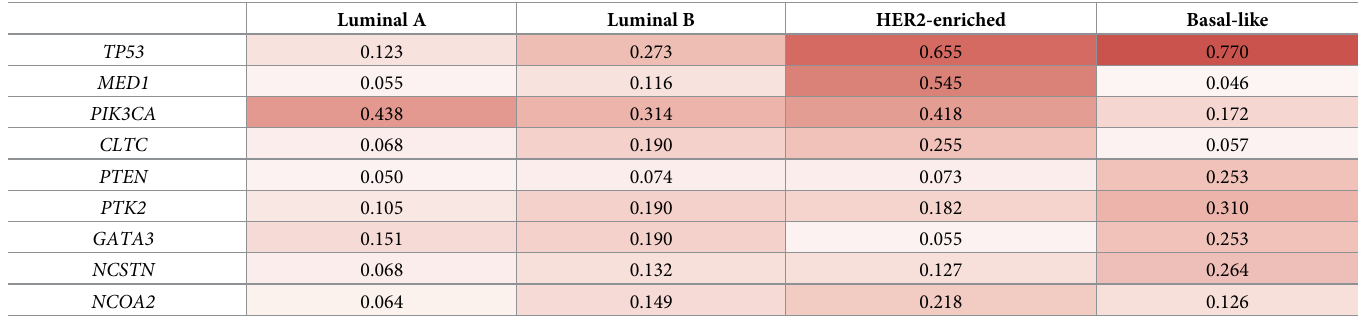
Table 6. Probabilities of source aberration with downstream target for breast cancer subtypes. For PAM50 subtypes of breast cancer, the heatmap represents the proba- bilities that the indicated gene is a DNA-aberrant source gene with some downstream RNA-aberrant target. The sources are selected from the set of core genes for cover- ings of the given tissue; the selection criterion is that the probability of a DNA-aberration is high for at least one of the subtypes for that tissue. Core sources with varying probabilities present interesting candidates for discrimination between subtypes. For example, the DNA-aberration frequency of TP53 is much higher in the HER2-e- nriched and Basal-like subtypes than in Luminal A and Luminal B, whereas an aberration in PIK3CA is less frequent among basal-like samples than among the other